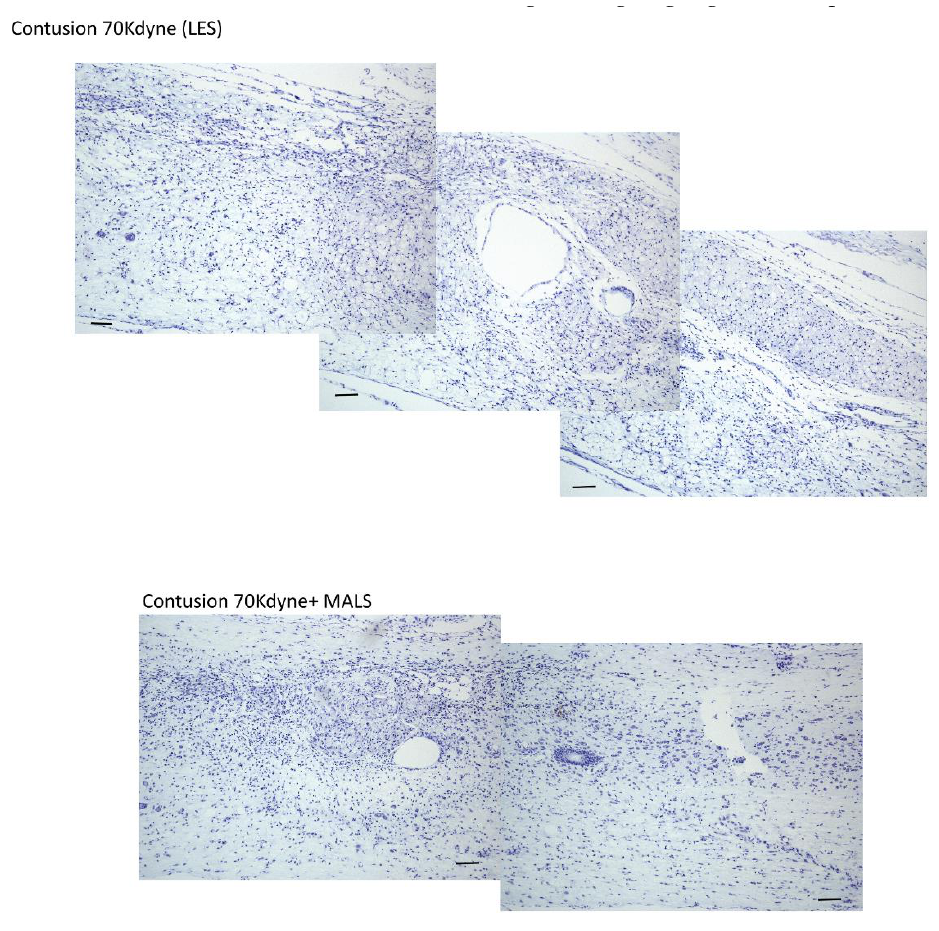
Figure 7. MALS transplanted spinal cords show increased neuronal presence cresyl violet staining of the lesioned spinal cord. The staining shows the presence of Nissl substance in the cytoplasm of neurons, more abundant at the epicenter of animals transplanted with MALS respect to LES. Scale bar: 100 µ m. The picture is representative of labeling performed in two di ff erent sections (n = 4 mice; 2 sections / mouse for each condition).